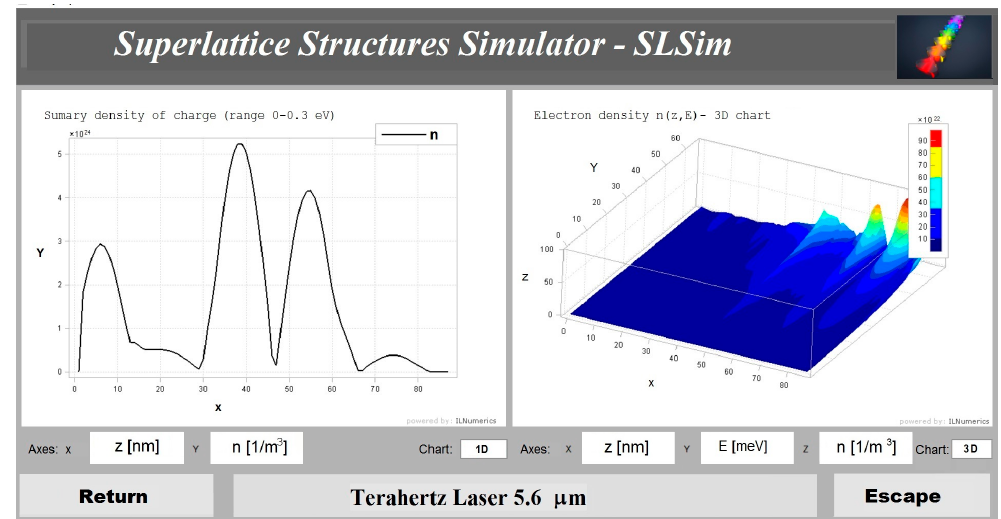
Figure 13. The exemplary graphs of simulation results based on user-defined templates: a 1D graph ( left ) and 3D graph ( right ).